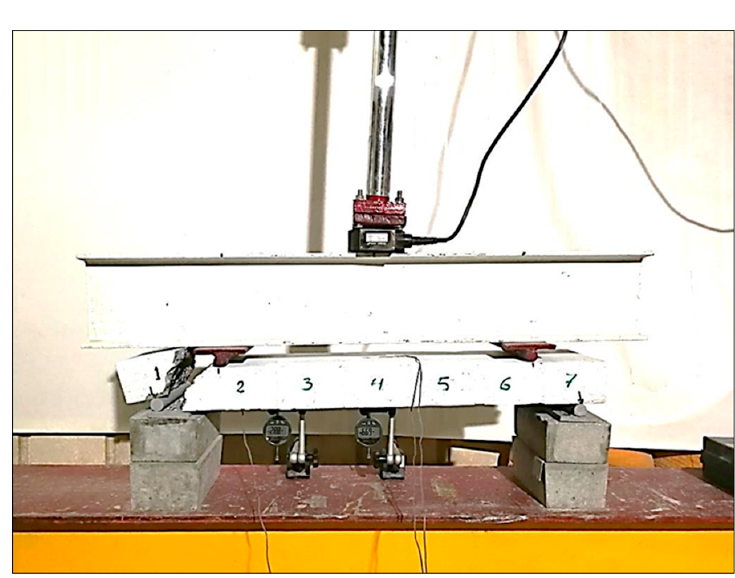
Figure 9. The failure mode of Beam SB7-ER-2A.